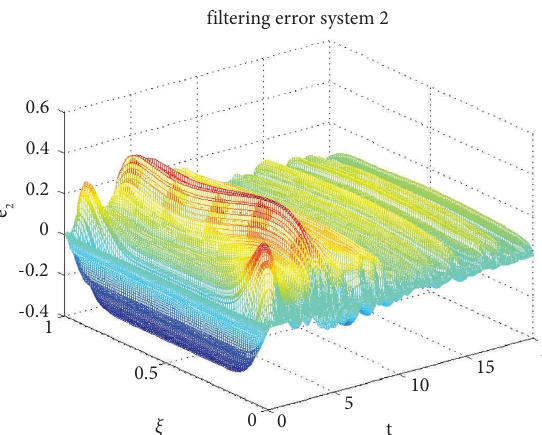
Figure 4: Filter error system development for flter 2.